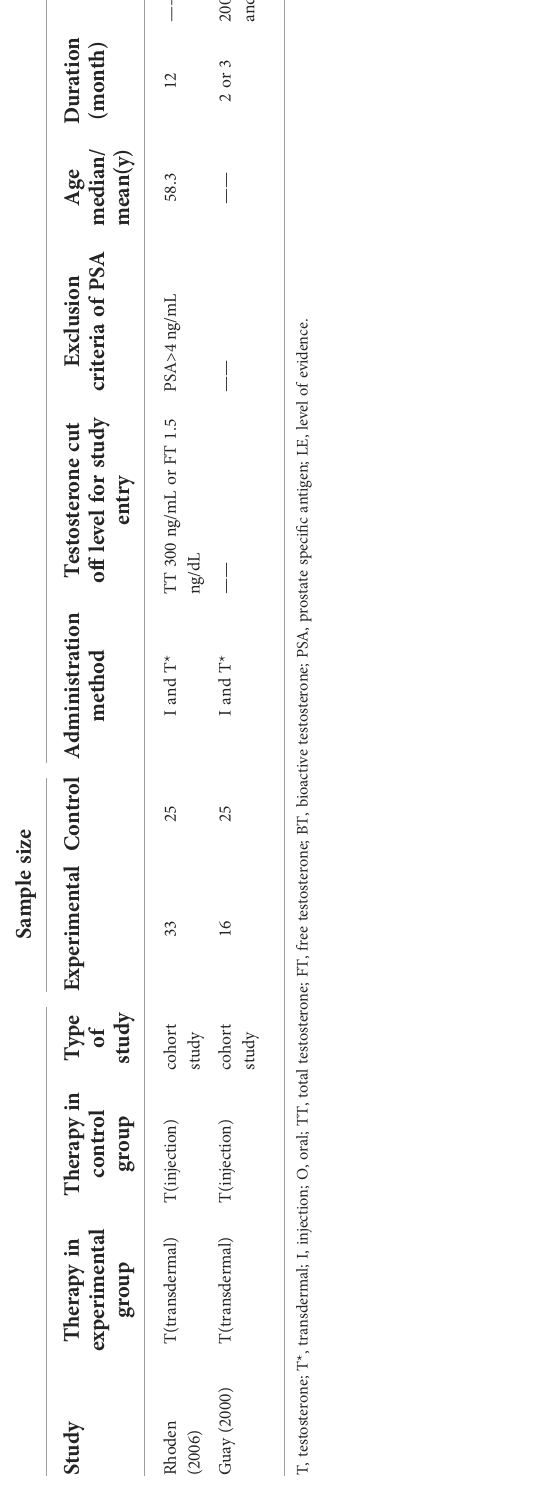
Supplementary Figure 2 displayed the results of our pairwise meta- analysis for the ef fi cacy of different administrations of testosterone compared with the control